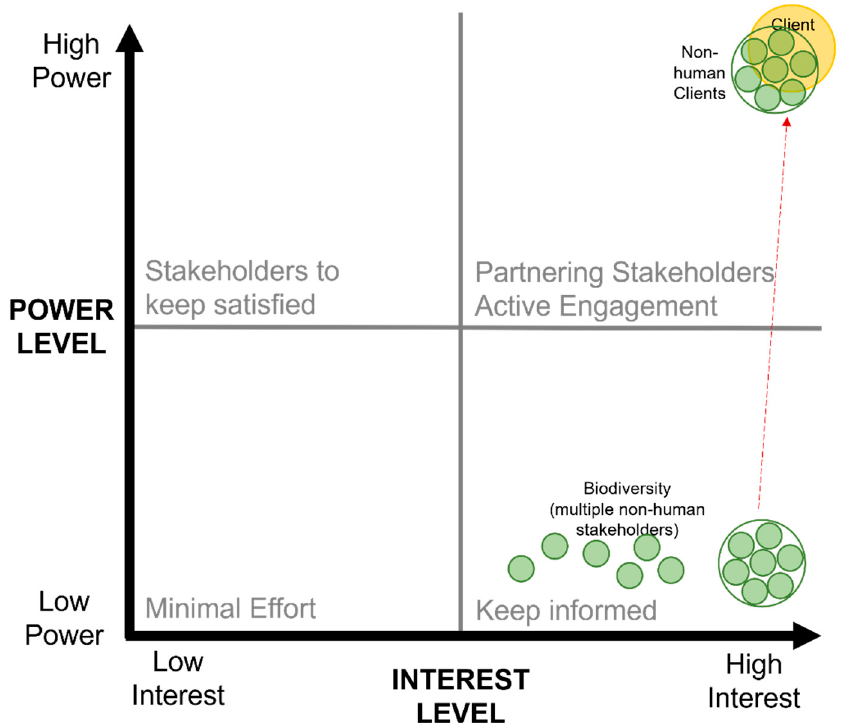
Figure 1. Power-Interest Grid. Adapted from Gardner, Rachlin [24] and Mendelow [22] to incorporate the construct of ‘species as clients’. The power-interest grid organises stakeholders depending on the level of interest and power they possess for any given project. While organised as a grid, it is also a continuum, with the black arrows showcasing the increase of interest and/or power. The grey text shows the level of engagement desired for each quadrant based on Gardner, Rachlin [24] and Mendelow [22]. We’ve incorporated ‘biodiversity’ as multiple green circles (with each species acting as a different stakeholder). In a tight circle on the right, those species are most impacted by the project. ‘Clients’, with the most power and interest, are in the top-right corner. The ‘species as clients’ construct argues for positioning biodiversity alongside human clients by intentionally prioritising the delivery of features and natural assets that enable client species’ survival within the urban landscape. The intentional shift of non-human stakeholders’ position in the gid is represented with a thin red arrow shifting the species within the circle to the top-right corner as ‘non-human clients’.